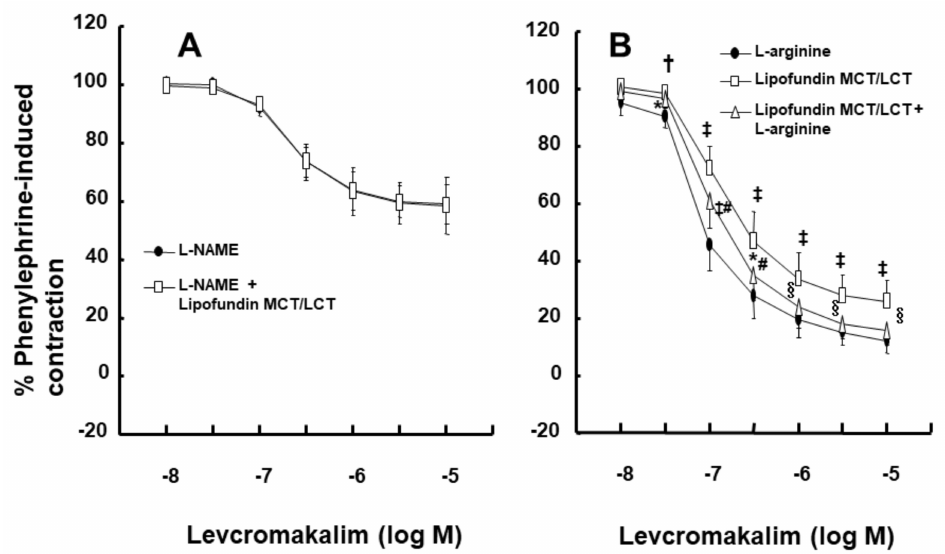
Figure 3. E ff ect of Lipofundin MCT / LCT (2%, n = 8) on the levcromakalim-induced vasodilation of isolated endothelium-intact rat aortae pretreated with N W -nitro-L-arginine methyl ester (L-NAME, 10 − 4 M) ( A ). E ff ect of L-arginine (10 − 4 M) and Lipofundin MCT / LCT (2%), alone ( n = 9) or combined ( n = 9), on the levcromakalim-induced vasodilation of isolated endothelium-intact rat aortae ( B ). Data are shown as the mean ± SD and expressed as the percentage of maximal contraction induced by phenylephrine (10 − 6 M). n indicates the number of isolated rat aortae. * p < 0.05, † p < 0.01 and ‡ p < 0.001 versus L-arginine alone. § p < 0.01 and # p < 0.001 versus Lipofundin MCT / LCT